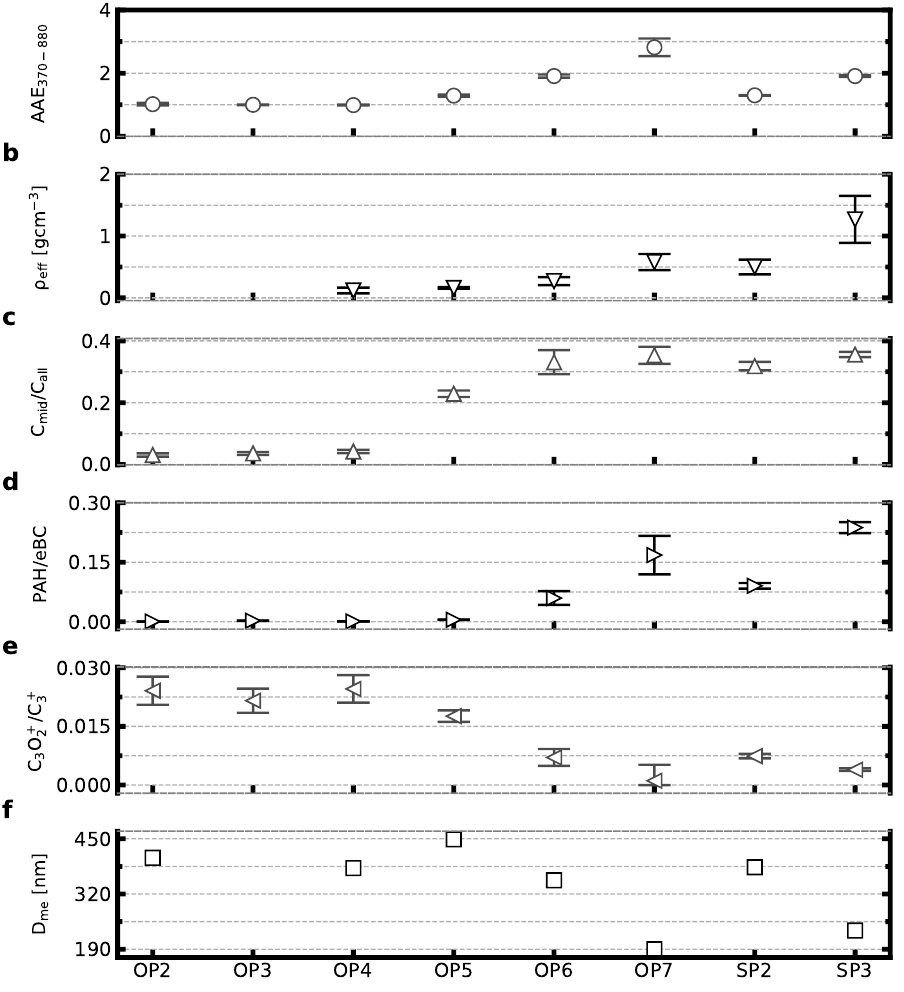
Figure 2. Physico-chemical properties of the eight studied samples (Table 1). From top to bottom: ( a ) absorption Angstrom exponent for wavelengths 370–880 nm, ( b ) particle effective density, ( c ) SP- AMS midcarbon to all carbon signal ratio, ( d ) SP-AMS concentration of particle phase polycyclic aromatic hydrocarbons normalised to aethalometer black carbon concentration, ( e ) SP-AMS C 3 O 2+ to C 3+ signal ratio, and ( f ) mean mobility equivalent diameter for each miniCAST setpoint sample. The sample setpoints on the x -axis are ordered by setpoint series and numbering. Effective density is omitted for OP2 due to low APM data quality, and effective density and mobility diameter is omitted for OP3 due to SMPS size distribution data not being monodisperse over the measurement period. A correction factor of 2.8 was used for the eBC data from this study. Uncertainties presented are of one standard deviation from the variability in recorded data during sampling. A point corresponds to 5–10 min of data